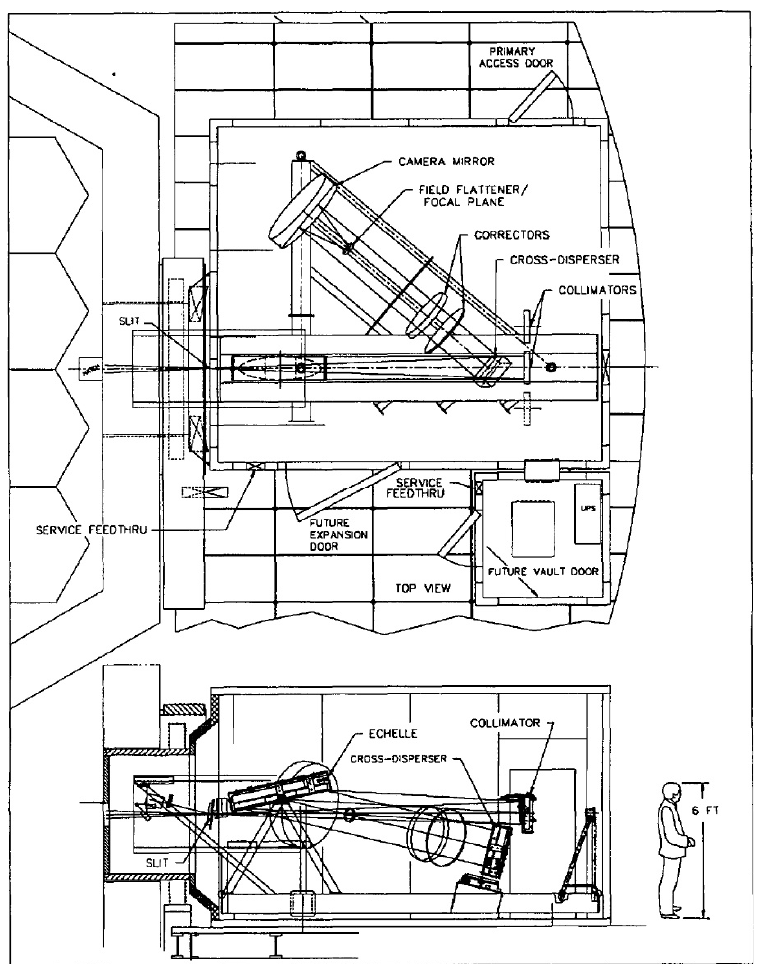
Figure 9. Top view and side view schematics of the HIRES (light from the telescope enters from the left) [86]. (Reprinted with permission from [86] © The Optical Society).